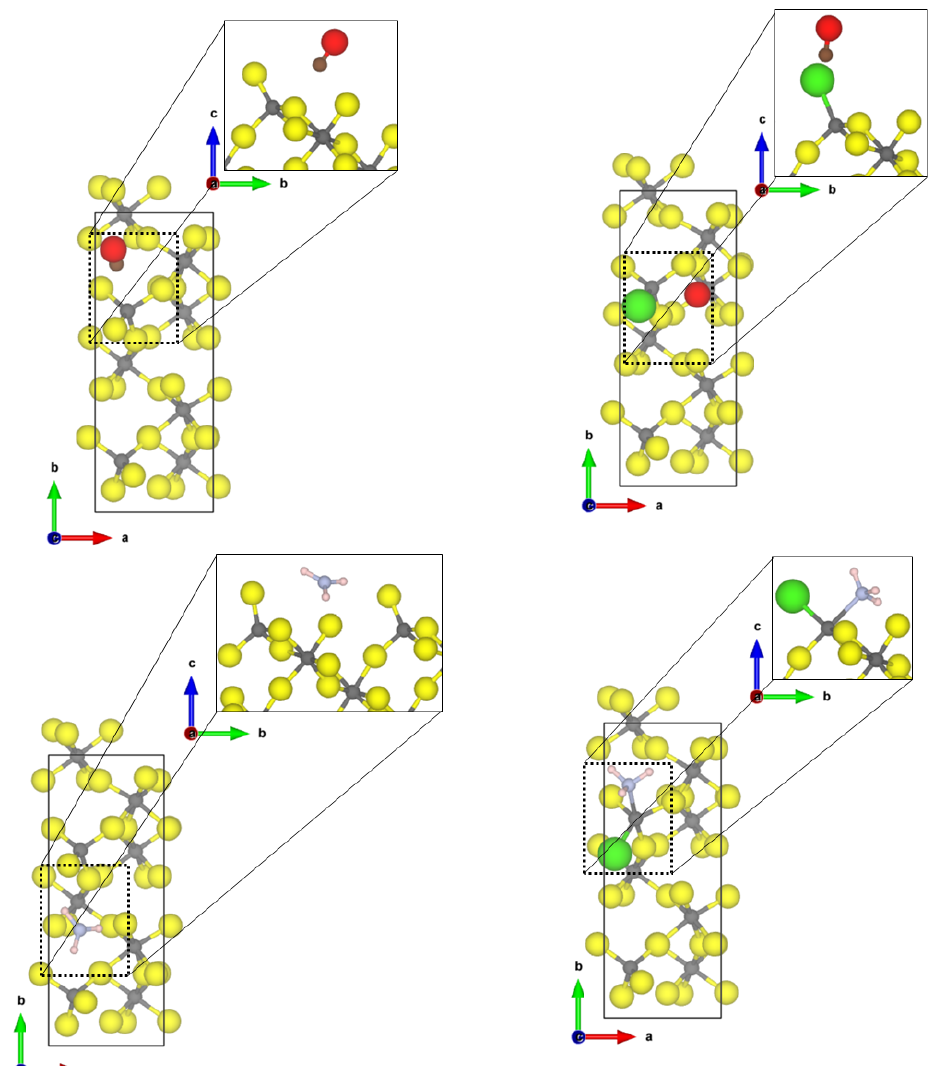
Figure 1. PBE-D3(BJ) optimized structures of the probe molecules CO ( upper row ) and NH 3 ( lower row ) on the 1 × 1 α -AlF 3 - ( left ) and 1 × 1 Cl-doped α -AlF 3 -(01¯10) surface; yellow = fluorine, grey = aluminium, brown = carbon, red = oxygen, blue = nitrogen, pink =